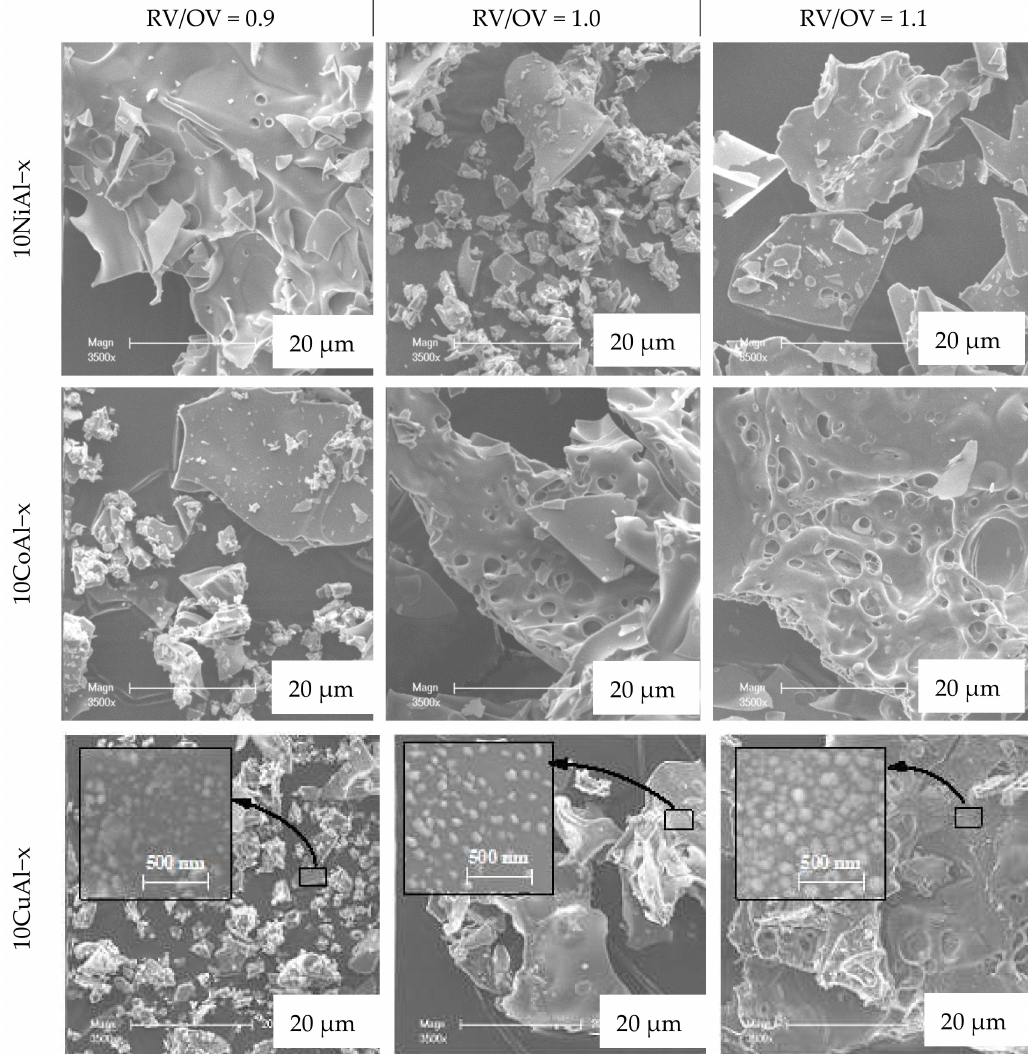
Figure 5. SEM images of the 10MAl − x calcined